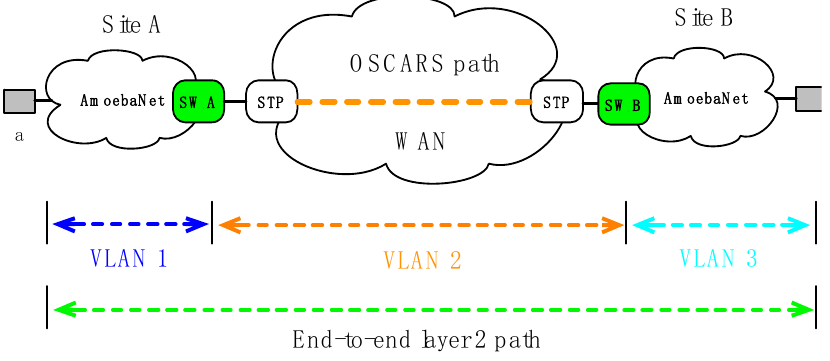
Figure 2. VLAN operations at Gateways.